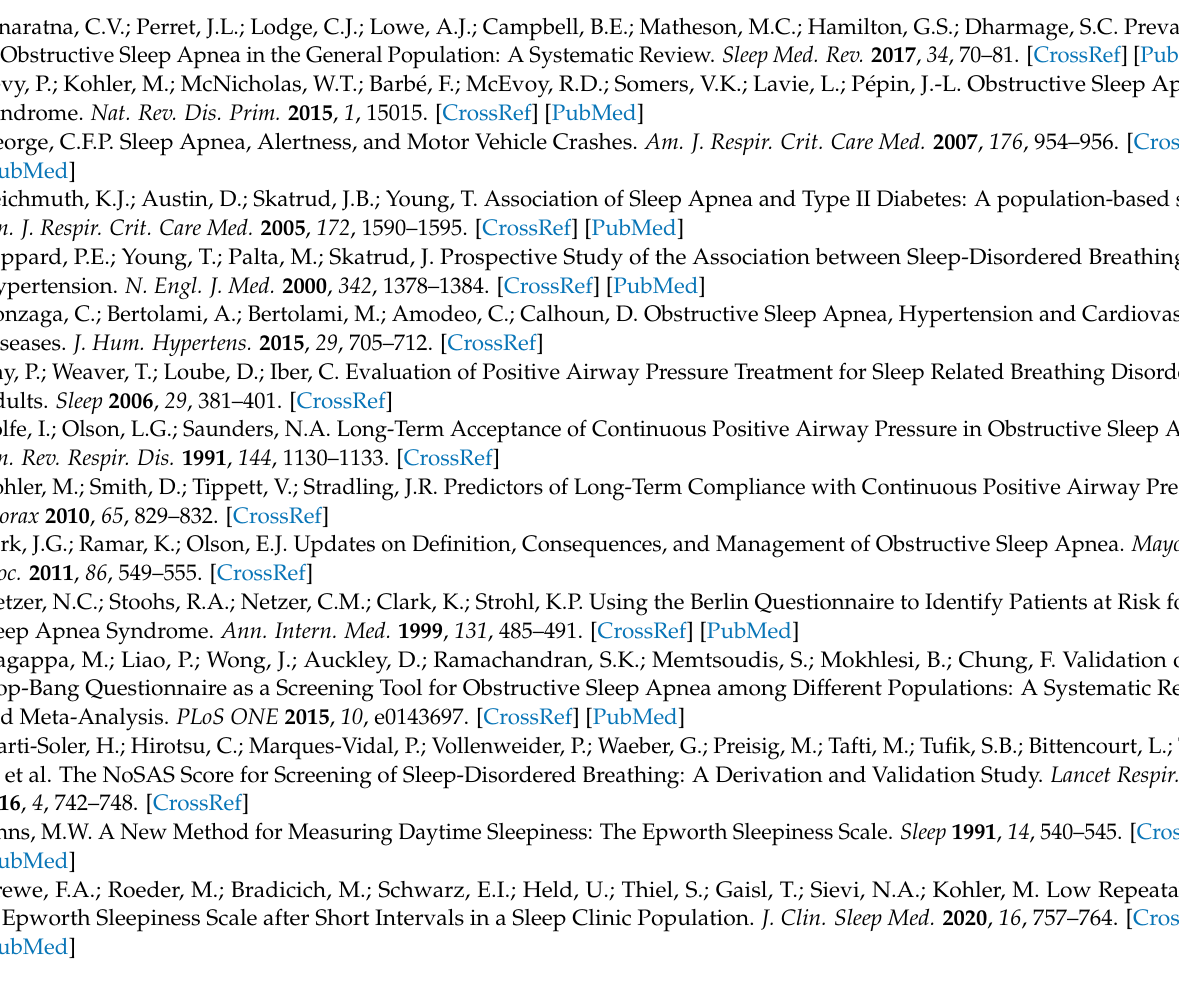
OSA group; Table S5: Classification performance of 42 confirmed markers applied on the different study